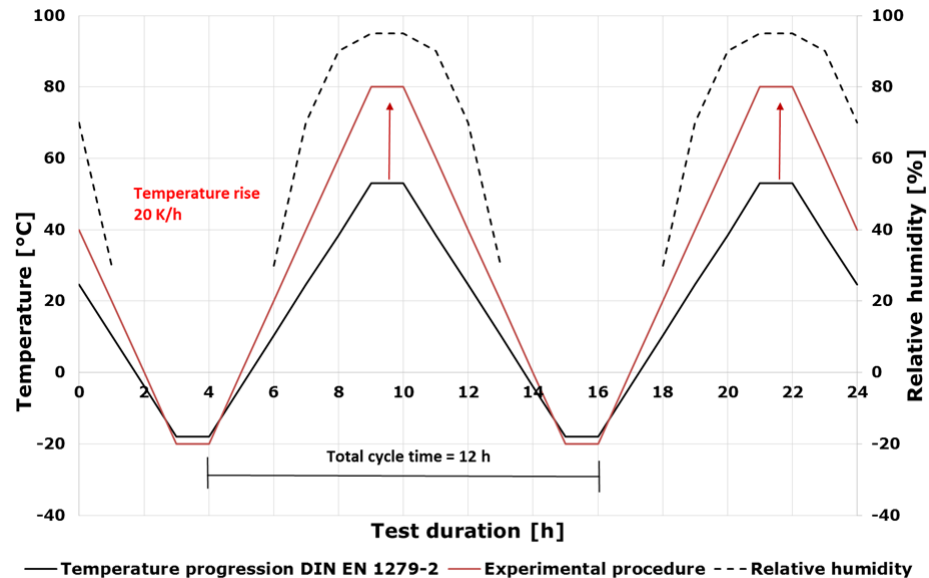
Fig. 6 Comparison of the artificial ageing program according to DIN EN 1279-2 and the experimental